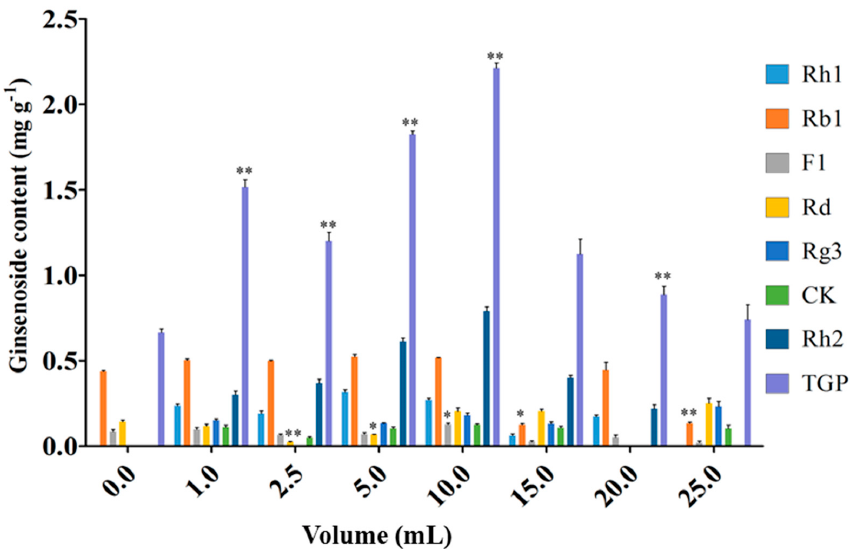
Figure 5. Effects of different endophyte suspension inoculation volumes on ginsenosides biosynthesis after 12 days of flask culture. TGP represents the total ginsenoside production. Data represents the mean ± standard deviation of three replicates. * Significantly different values between the treatment and control groups at p < 0.05. ** Very significantly different values between the treatment and control groups at p < 0.01.